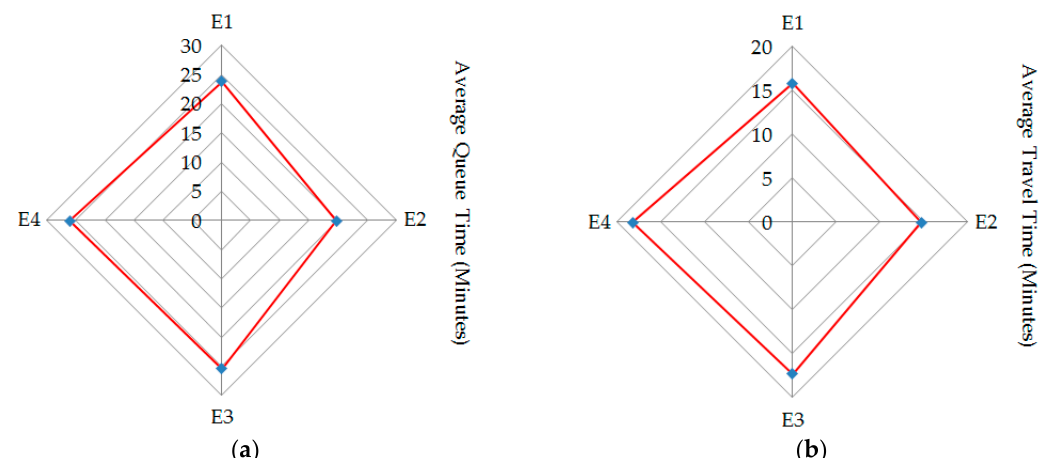
Figure 8. Average queuing time and average travel time of the vehicles evacuated from the four exits of the parking lot. ( a ) Average queuing time. ( b ) Average travel time.